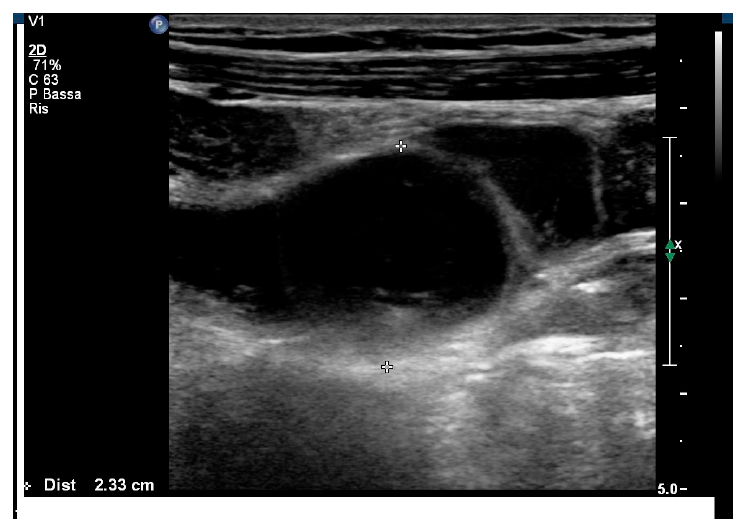
Figure 1. Transverse real-time ultrasound scan of the bowel performed with a high-frequency transducer (5–12 MHz), showing moderately dilated bowel loops with a slightly thickened bowel wall and increased moderately echoic luminal content.